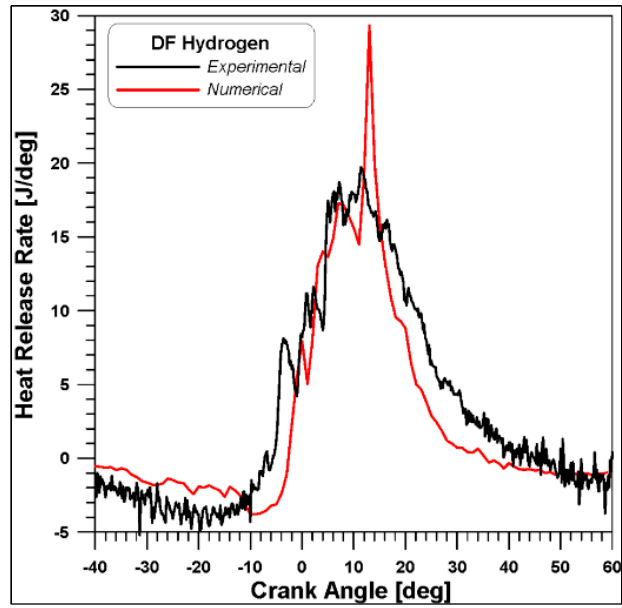
Figure 14. Rate of heat release. Experimental vs Numerical.